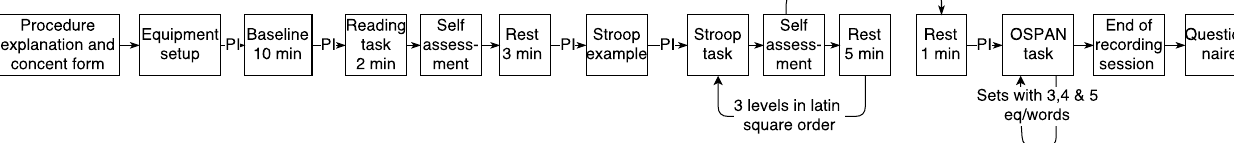
Figure 1. Chart of the flow of tasks and resting periods for the whole duration of one experiment. Progress Instructions PI depicts instructions given to the participants in between tasks to be read out